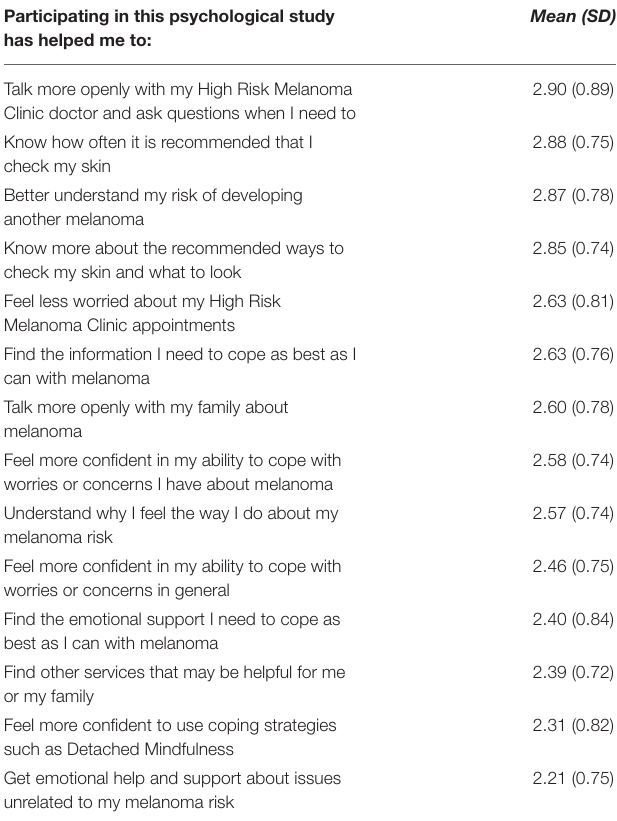
TABLE 3 | Perceived effects of participation in the intervention ( n = 67), with ratings from 0 (“strongly disagree”) to 4 (“strongly agree”). Participating in this psychological study has helped me